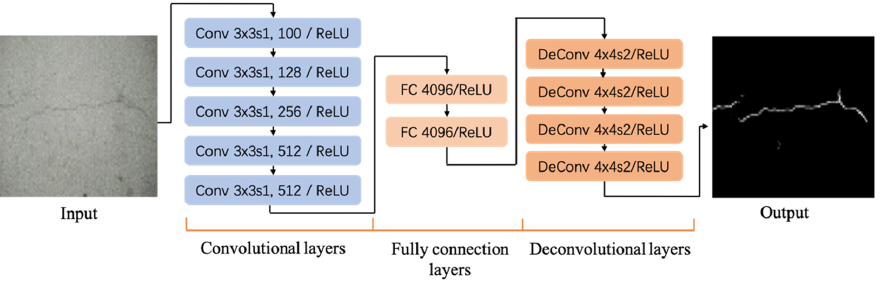
Figure 11. Pavement crack segmentation network structure.